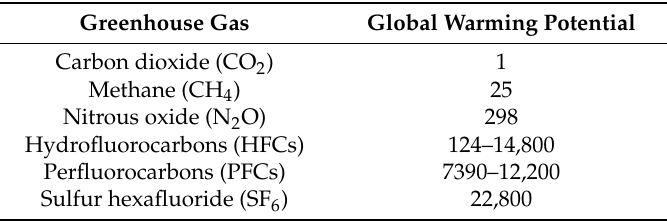
Table 1. Global warming potential greenhouse